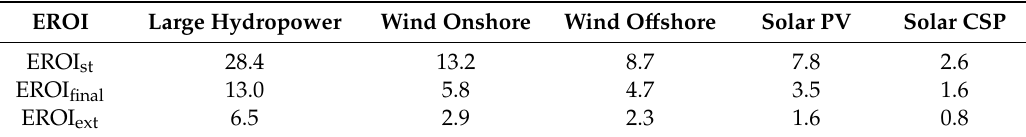
Table 3. EROI results. Current standard, final, and extended EROI for the renewable electricity generation technologies studied in this work. Performance factors and mineral recycling rates are set at current global average